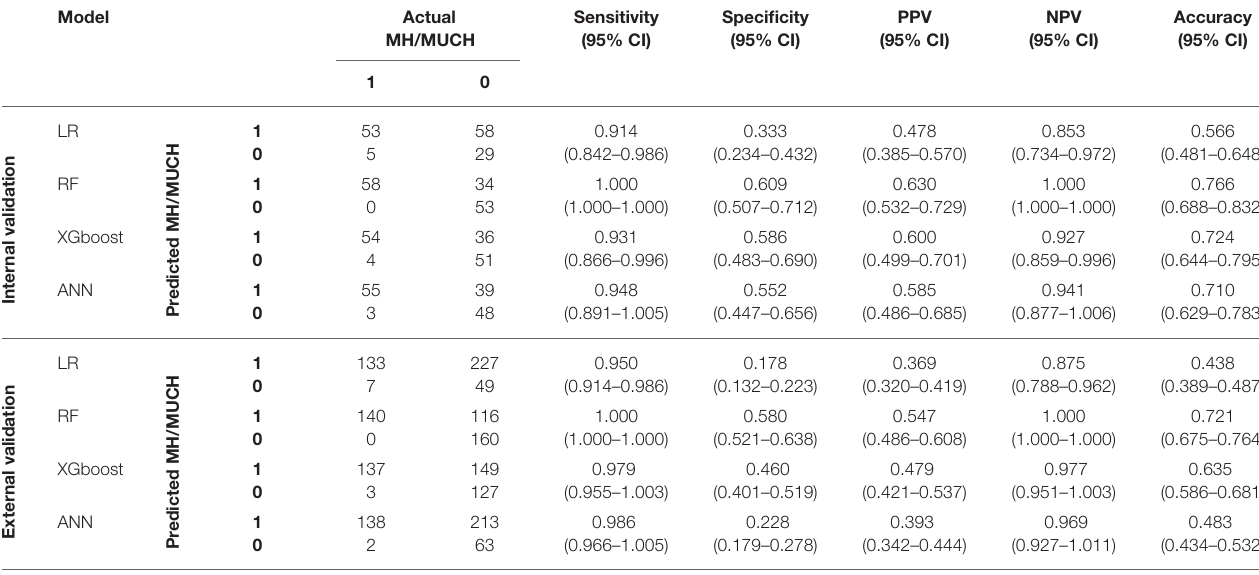
TABLE 3 | Confusion matrix and performance metrics among the developed models for MH/MUCH prediction (1 represents with MH/MUCH; 0 represents without MH/MUCH).